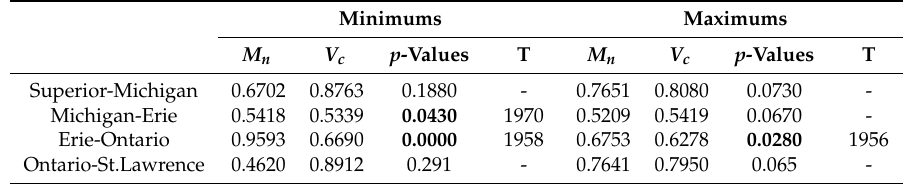
Figure 9. Analysis of dependence using the copula method. Temporal variability of M n values derived for monthly mean maximum water level series for Lakes Erie and Ontario (1918–2012). The horizontal red line shows the critical value of V c . The vertical line represents the timing of the change of dependence between the water levels. Table 4. Analysis of dependence between lakes monthly mean water levels. Results obtained using the copula